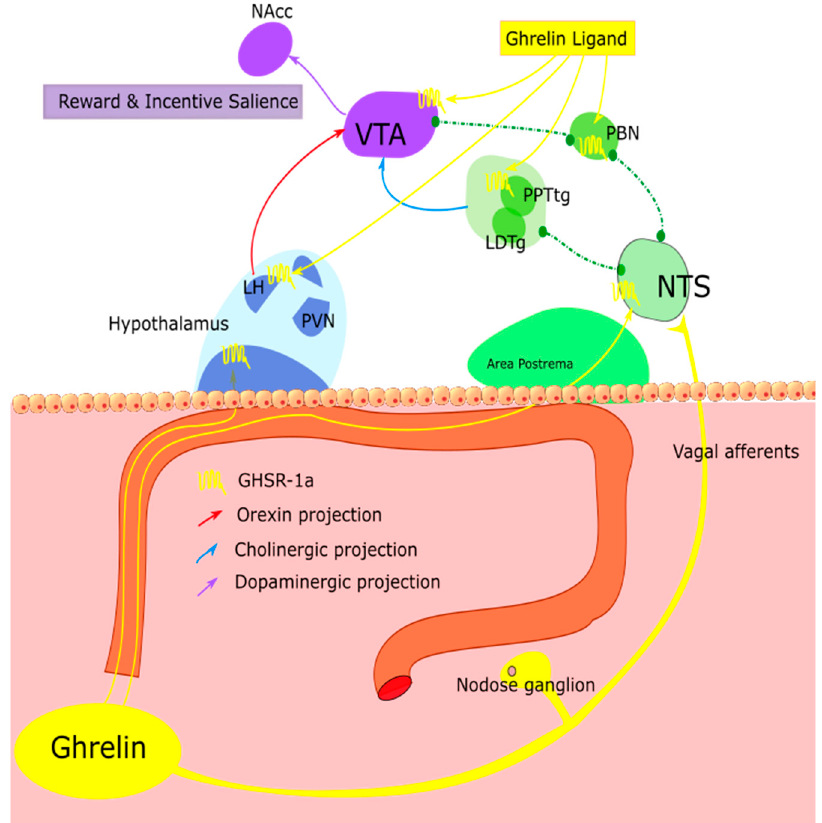
Figure 2. Direct and indirect access of ghrelin to the mesolimbic circuitry; the routes by which ghrelin and ghrelin ligands can traverse the blood-brain barrier (BBB). Direct activation of the mesolimbic circuitry can be attained by a centrally penetrant ghrelin agonist or by ghrelin which freely diffuses across the BBB. Indirect activation of mesolimbic circuitry is attained via the homeostatic mechanism through the “leaky” BBB capillaries at the median eminence and the area postrema. Ghrelin signalling initiating in the arcuate nucleus increases the rewarding value of food via orexin projections (red arrow) to the ventral tegmental area (VTA) from the lateral hypothalamus (LH). The nucleus tractus solitarius (NTS) displays connections with the hypothalamus, as well as the parabrachial nucleus (PBN), the laterodorsal tegmental area (LDTg) and pedunculopontine tegmental area (PPTtg), all of which have confirmed roles in either reward signalling (LDTg and PPTtg, blue arrow) or gustatory processes (PBN). Central penetration of ghrelin compounds may act directly on GHSR-1a expressed in these regions to modulate incentive salience of food (purple arrow).